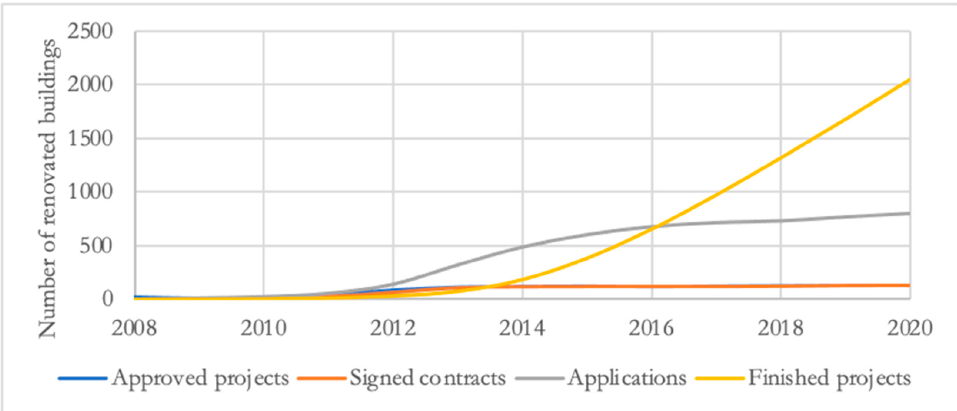
Figure 19. Simulated number of renovated multi-family buildings with combined penalty–reward scheme and EU funding.